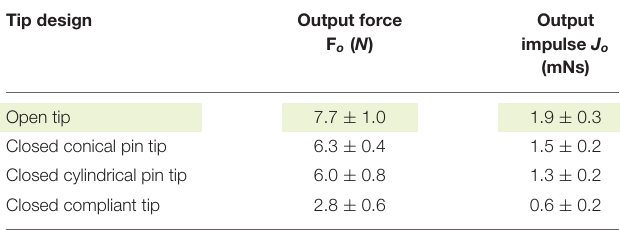
TABLE 4 | Overview of the results (mean ± standard deviation, n = 3) of the tip design experiment.